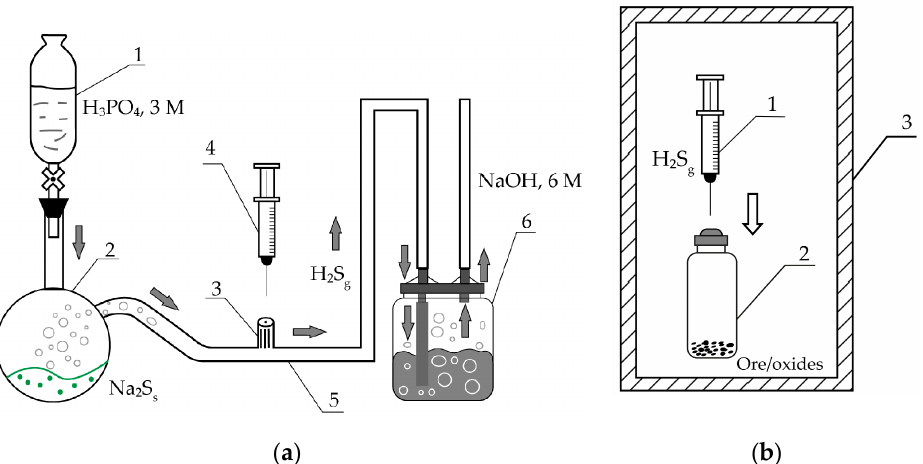
Figure 2. ( a ) Hydrogen sulfide synthesis unit: 1—drop funnel, 2—Wurtz flask, 3—sampling fitting with rubber seal, 4—gas syringe, 5—silicone hose, 6—barbotage unit; ( b ) hydrogen sulfide sorption unit: 1—gas syringe, 2—ore-containing glass vessel for the sorption process, 3—thermostatic jacket.